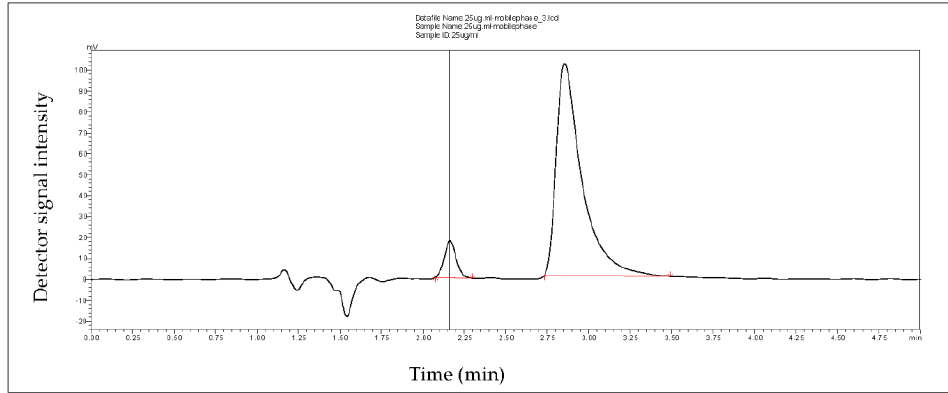
Figure 2. Chromatogram of dexamethasone treatment.